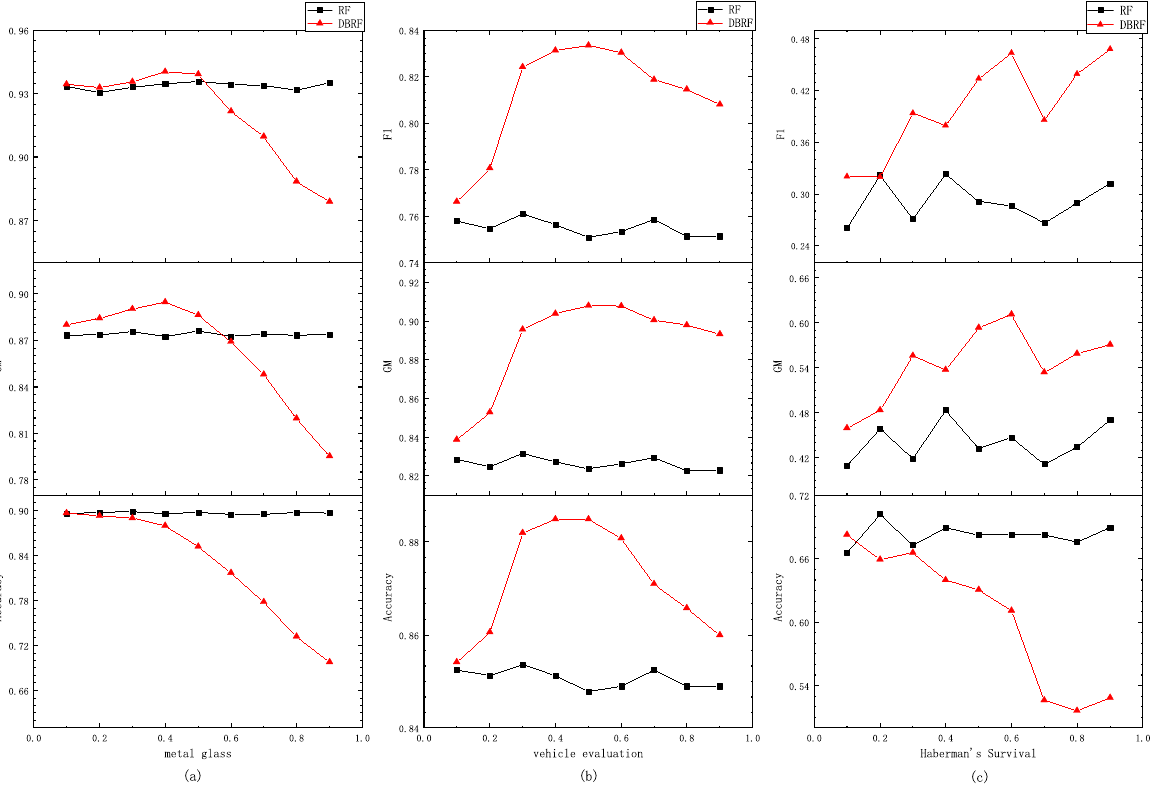
Figure 6. Three real-world datasets on the ( a ) metal glass, ( b ) vehicle evaluation, and ( c ) Haberman’s survival with different p . F1 focused on the minority class: comparisons with different p . The horizontal axis is p , and the vertical axis is accuracy , F1, and GM in the different sub-figures. For metal glass, η = 80; for Haberman’s survival, η = 2; for vehicle evaluation, η = 1. Figure 7 shows a box plot of the 10-fold cross-validation on the three datasets with the best p and η . Figure 7 indicates that the maximum value of DBRF was larger than that of the base algorithm RF, and the minimum value was larger than that of RF. In addition, the distribution of the 10 experimental results revealed that DBRF was relatively